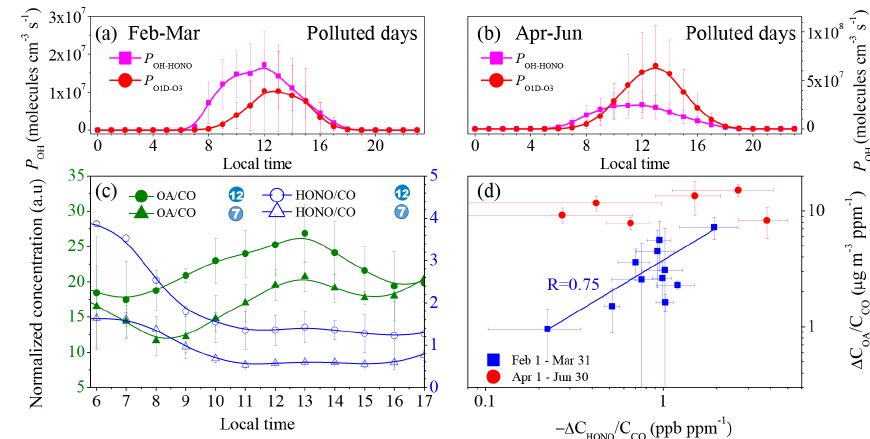
Figure 2. Contribution of HONO to OH production and the correlation between the OA and HONO concentrations. Diurnal production rates of OH from the photolysis of HONO and O 3 on polluted days, with PM 2 . 5 concentrations of greater than 50µgm − 3 and RH values of less than 90%. (a) From 1 February to 31 March; (b) from 1 April to 30 June; (c) daytime variation in the OA / CO and HONO / CO concentrations for the 7th and 12th episodes; and (d) correlation between the daytime increase in OA / CO and the HONO / CO